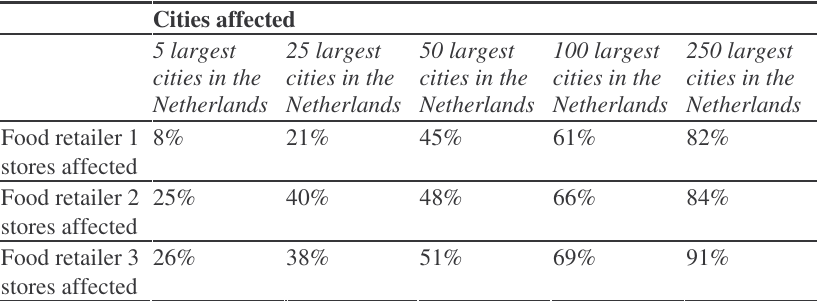
Table 3. Stores affected per scenario part and retailer Cities